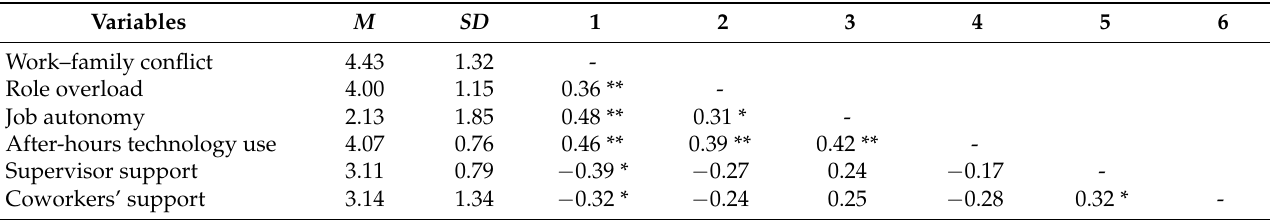
Table 1. Means, standard deviations, and intercorrelations.